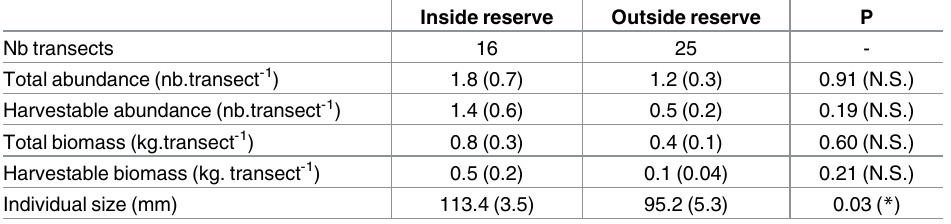
Table 2. Effects of protection on trochus ( Tectus niloticus ) populations in the Takara reserve,North Efate, Vanuatu. Means ( ± SE) for abundance,biomassand individualsize inside vs. outside the marine reserve. Results of Mann Whitney’s U test: * p <